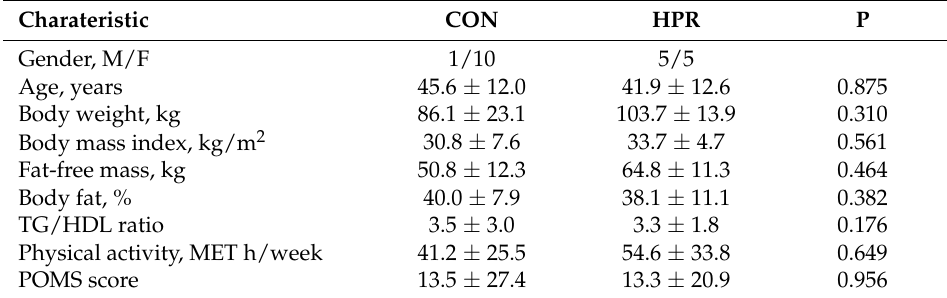
Table 2. Baseline demographics for study participants randomized to the energy-restricted diet composed of traditional breakfast cereal and gluten-free pasta dishes at lunch and dinner (CON; n = 11) or high-protein breakfast cereal and high-protein pasta dishes at lunch and dinner (HPR; n = 10) *